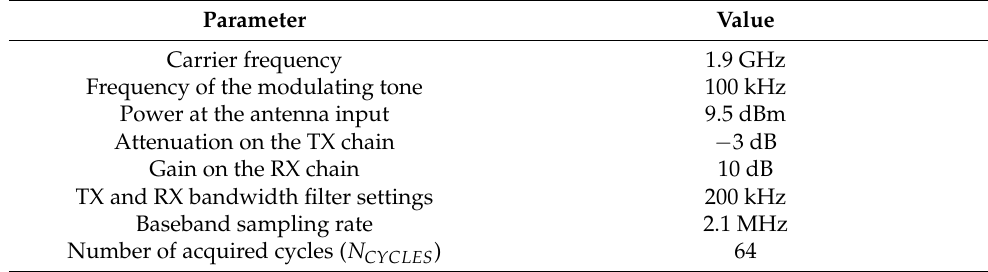
Table 2. Acquisition settings for the presented results.